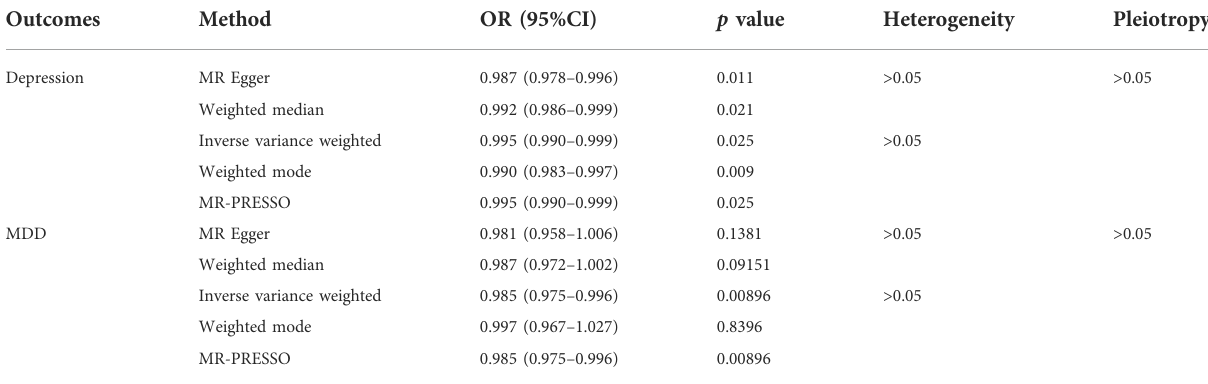
TABLE 1 Two-sample MR estimates for the effect of SLE on depression or